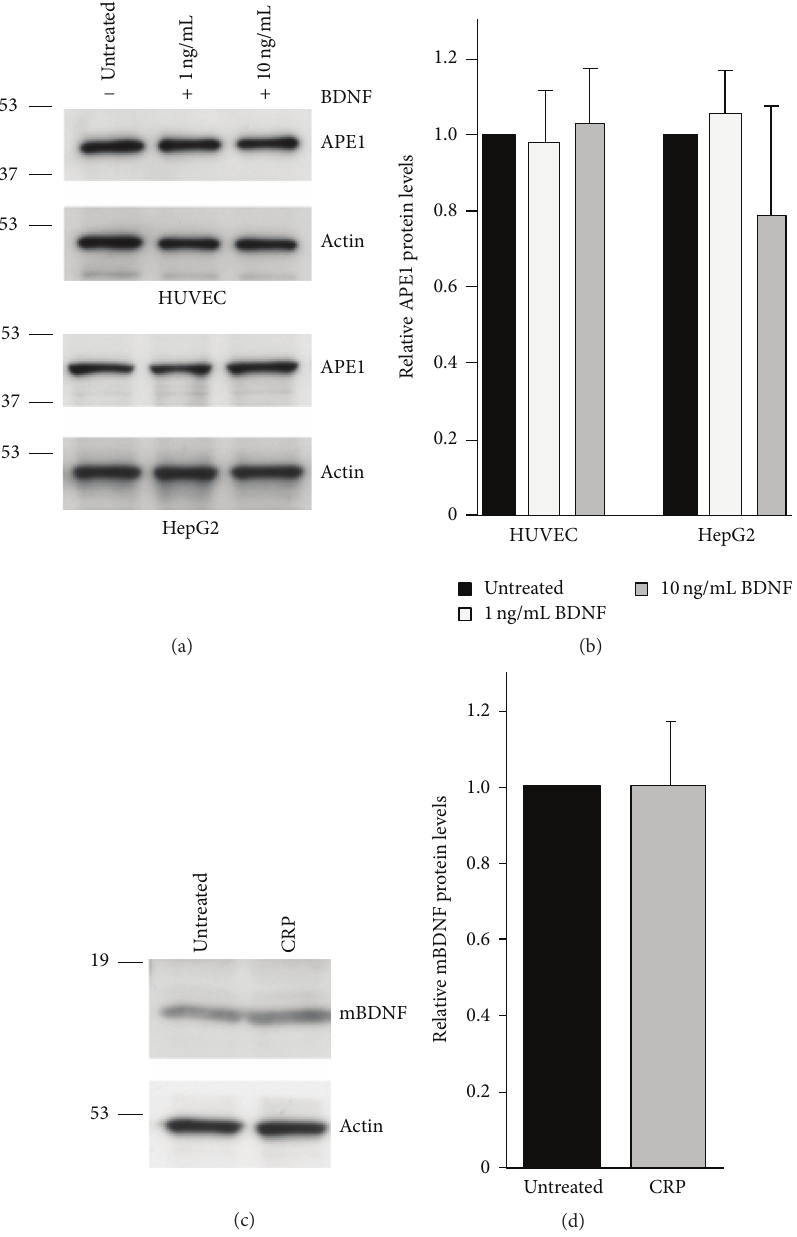
Figure 4: CRP or BDNF treatment does not affect BDNF or APE1 levels, respectively. (a) HUVECs or HepG2 cells were untreated or treated with the indicated concentrations of BDNF for 18 hrs. Cells were lysed, separated by SDS-PAGE, and probed with anti-APE1 and anti-actin antibodies. (b) APE1 protein levels were quantified from immunoblots and normalized to actin. The histograms represent the normalized mean + SEM ( 𝑛 = 5 for HepG2 and 𝑛 = 3 for HUVEC). (c) HUVECs were treated for 18hrs with 25 𝜇 g/mL CRP. Cells were lysed, separated by SDS-PAGE, and probed with anti-BDNF and anti-actin antibodies as a loading control. Mature BDNF (mBDNF) is indicated. (d) BDNF protein levels were quantified from immunoblots and normalized to actin ( 𝑛 = 5 ).